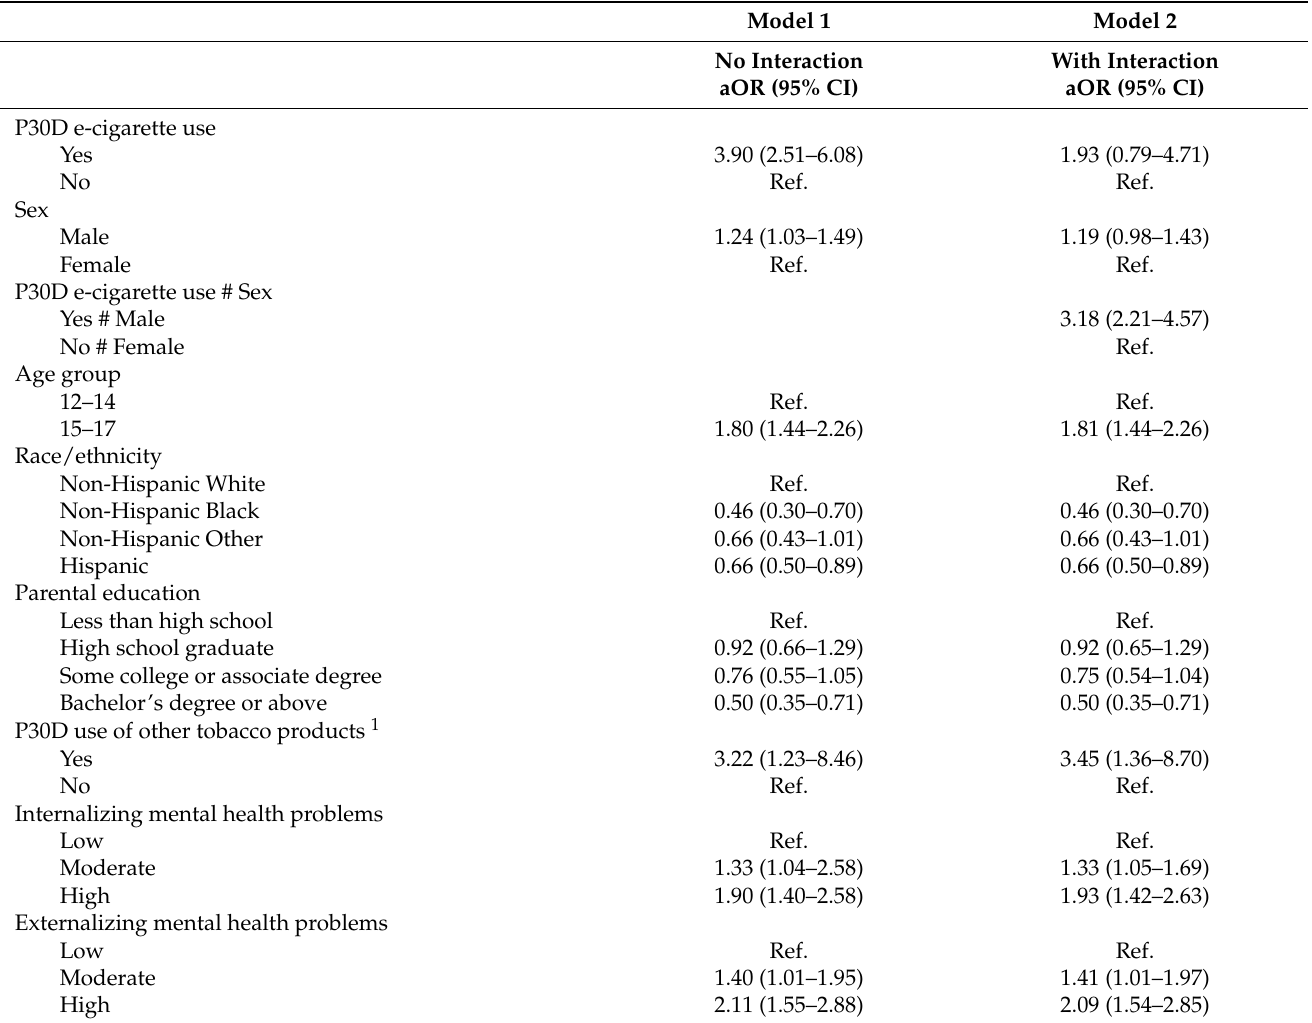
Table 3. Adjusted odds ratios (aORs) of P30D cigarette smoking at 12-month follow-up waves among adolescents (12–17 years of age) who were never cigarette smokers at baseline waves.